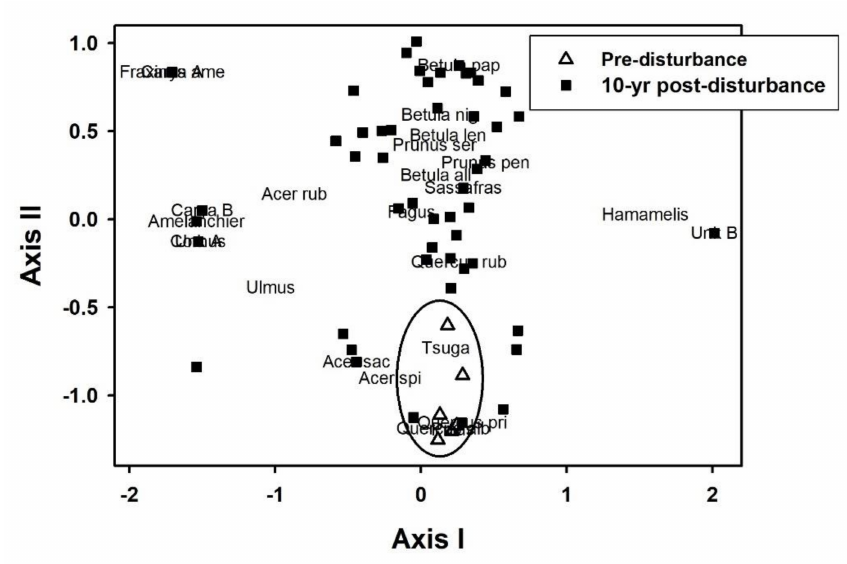
Figure 7. Nonmetric multidimensional scaling ordination of pre-disturbance canopy trees (open triangles) and 1999 seedlings and saplings (closed squares). Ellipse encloses all of the pre-disturbance sample plots. Positions of species in ordination space are also shown with text. Final stress for 2-dimensional solutions =